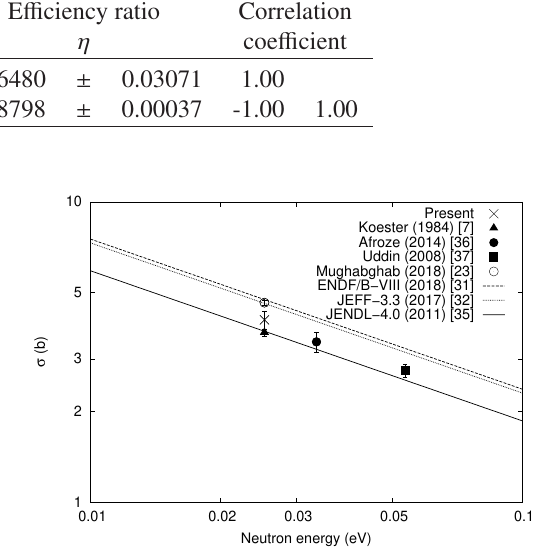
Figure 2. Comparison of our thermal cross section (revised from Ref. [18]) with two cross sections measured with filtered neutron beams at 0.0334 eV [36] and 0.0536 eV [37] and some recom- mended / evaluated cross